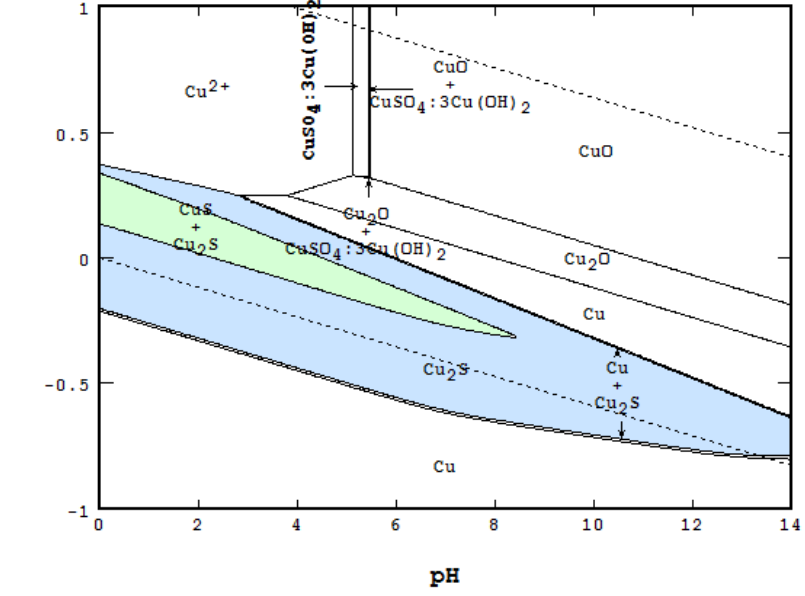
Figure 11. Mass-balanced Eh-pH diagram for the Cu–S–water system with copper slightly in excess. Σ Cu = 0.001 M and Σ S = 0.0009 M.